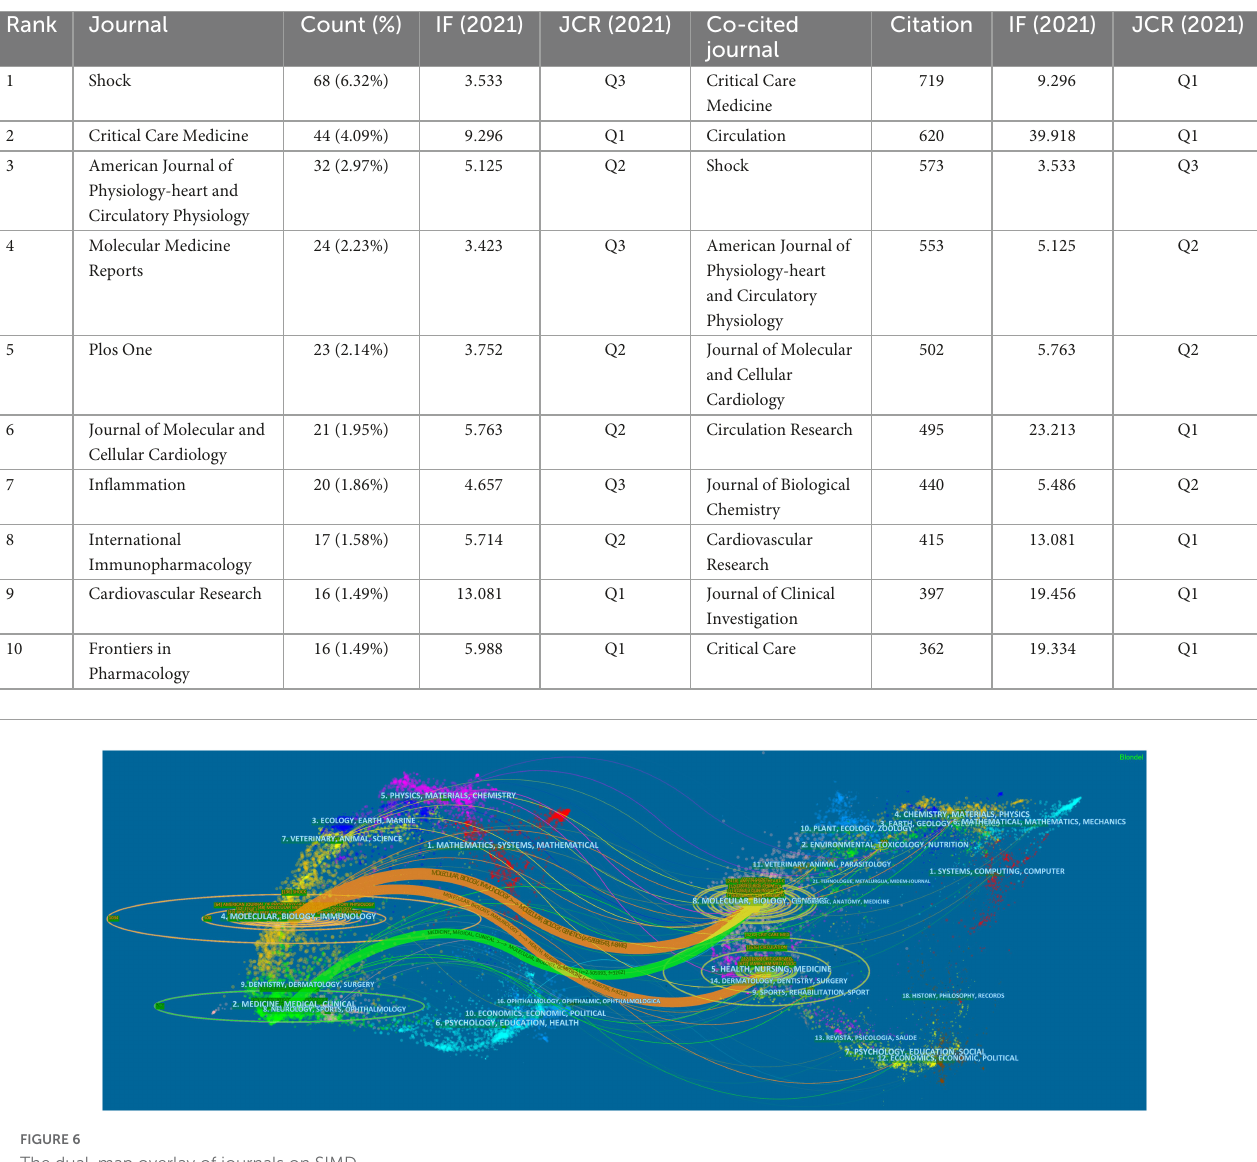
FIGURE6 The dual-map overlay of journals on